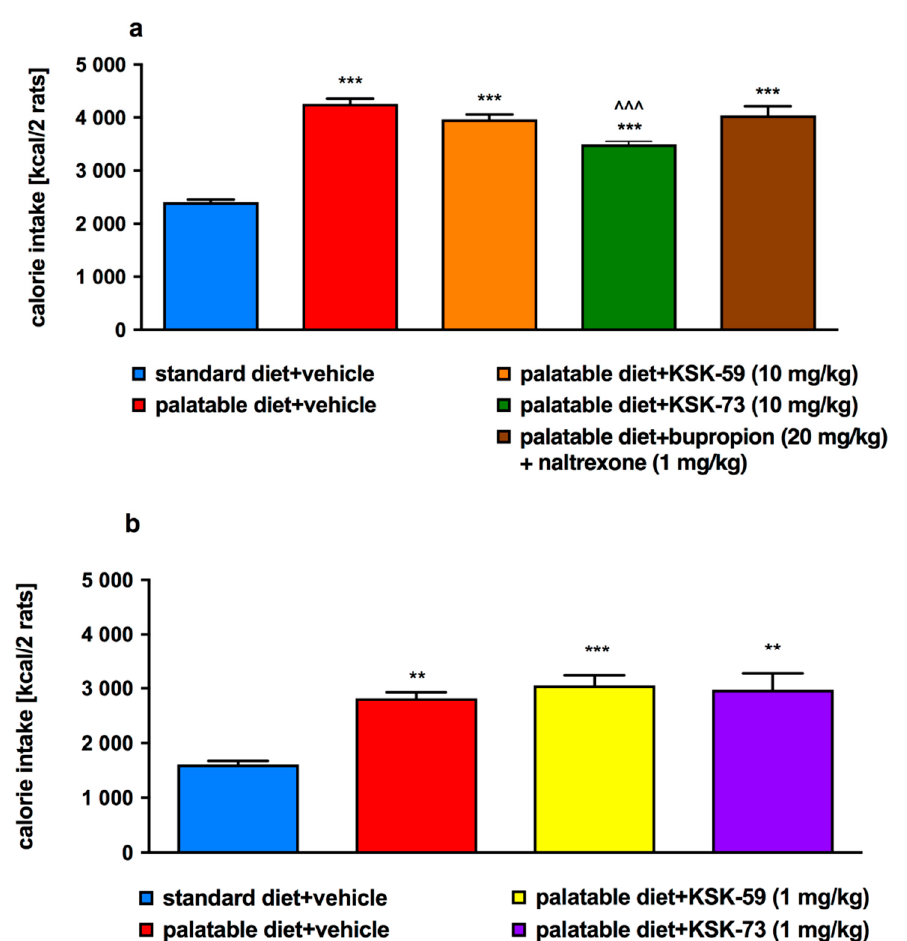
Figure 4. Effect of administration of the tested compounds or bupropion/naltrexone on calorie intake. The amount of calories consumed by rats treated with test compounds KSK-59 or KSK-73 at a dose of 1 mg/kg b.w. ( a ) or a dose of 10 mg/kg b.w. ( b ) compared to control groups. Results are expressed as means ± SEM, n = 6. Comparisons were performed by one-way ANOVA, Tukey’s post hoc tests. * Significant against control rats fed standard diet; ^ significant against control rats fed palatable diet; ** p < 0.01, ***, ^^^ p < 0.001.